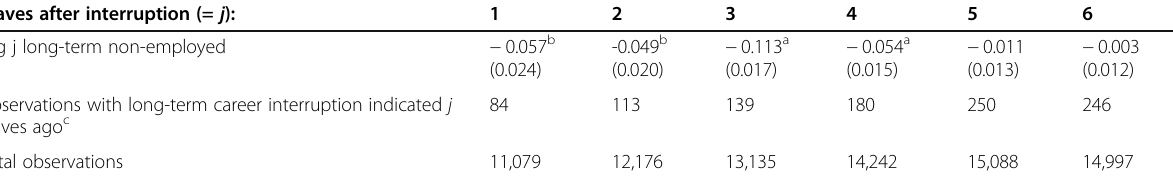
Table 4 Future wage effects of a long-term non-employment spell for labor market attached workers. Dependent variable: log real hourly wage, j waves after the interruption Waves after interruption (= j ):